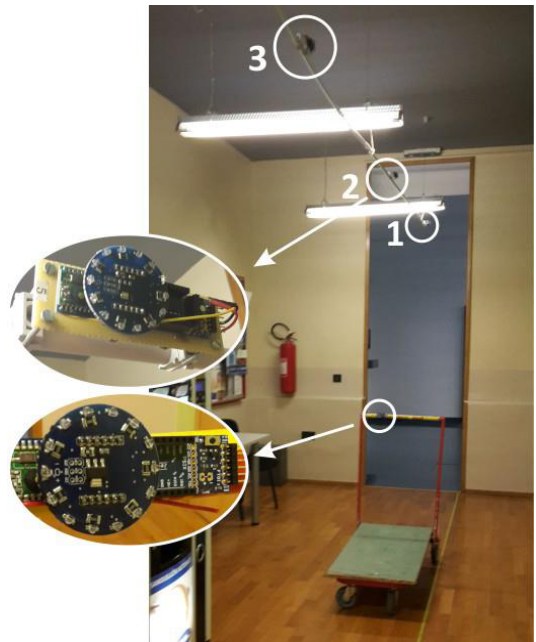
Figure 15. E1-Testbed: numbered nodes (1, 2, 3) are equipped with an IR AoA sensor, and on the handle of the cart is an IR transmitter. Its design is similar to the sensing node since the IR AoA sensor has IR diodes on the opposite side of the IR phototransistors.